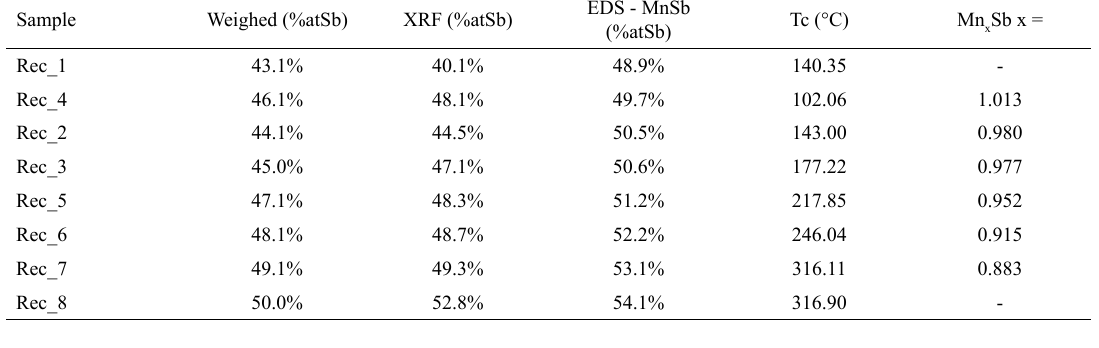
Table 2. chemical composition of samples (weighed and XRF) and EDS for Mn